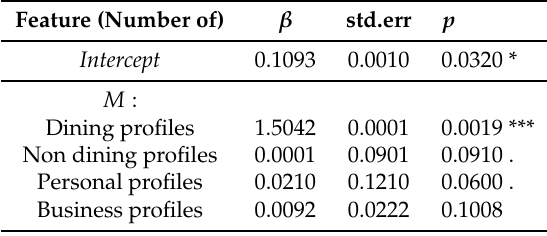
Table 3. Regression results for the relationship between the social environment ( M ) and user’s dining posting behavior on Instagram ( DV ): M → DV with DV being the total number of dining posts made by an individual. Feature (Number of) β std.err p